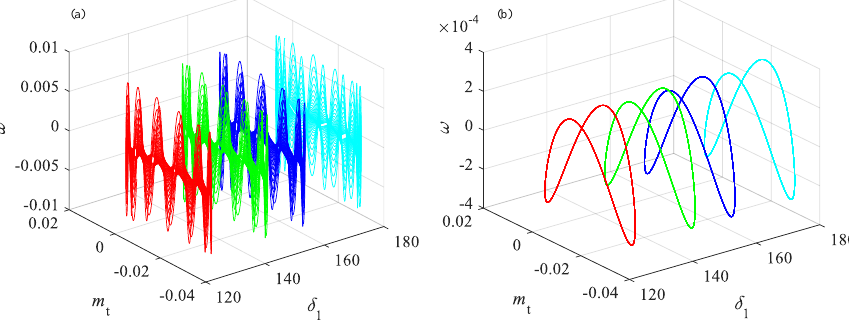
Figure 1. Phase diagrams of the system with increase initial value of δ 1 ( t 0 ) ( a ) t ∈ [ 0, 350 ] and ( b ) t ∈ [ 350, 500 ]